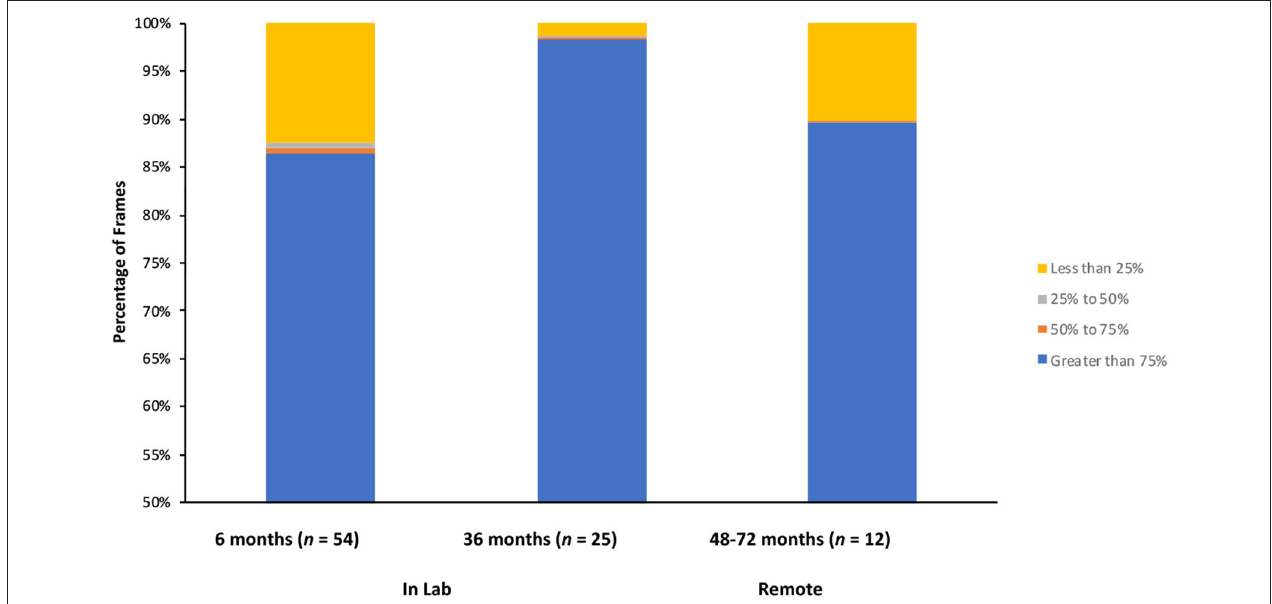
FIGURE 3 | Distribution of confidence ratings: percentage of frames with confidence ratings of 75% or higher (in blue), 50–75% (orange), 25–50% (gray), or < 25% (yellow) for 6-month-old infants (tested in the lab), 36-month-old children (tested in the lab), and 48–72-month-old children (tested remotely). For each participant, we calculated the percentage of frames in each quartile, and then averaged across participants to get these numbers.